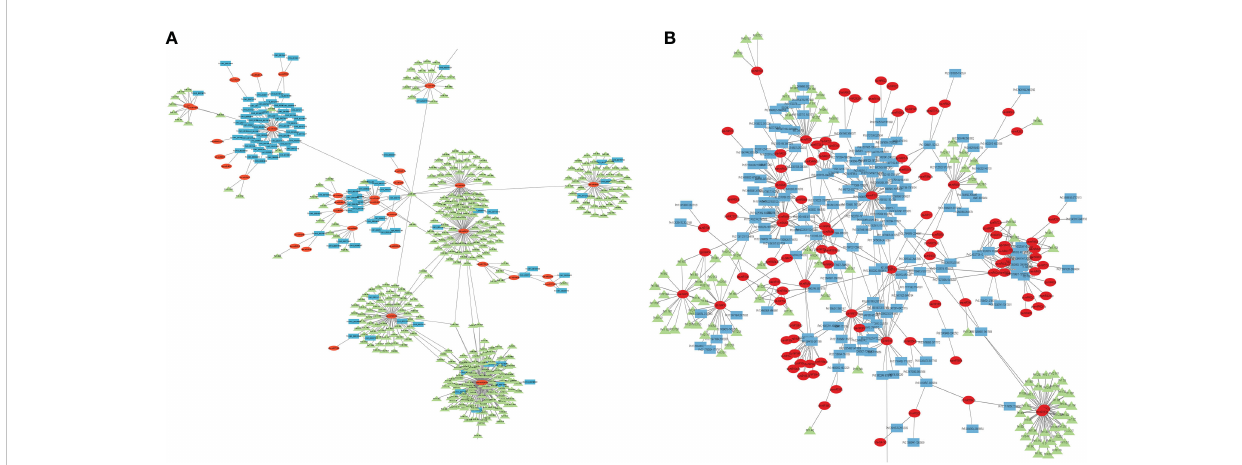
FIGURE 7 Cytoscape diagram showing the ceRNA network relationship between (A) lncRNA – miRNA – mRNA and (B) circRNA – miRNA – mRNA; green triangles representing mRNA, red ellipses representing miRNA, and blue rectangles representing